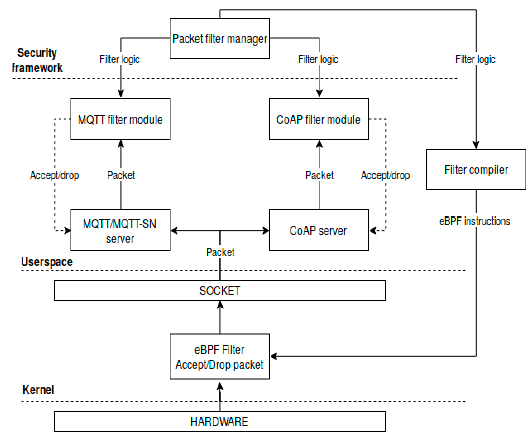
Figure 5. The architecture of the gateway packet filtering